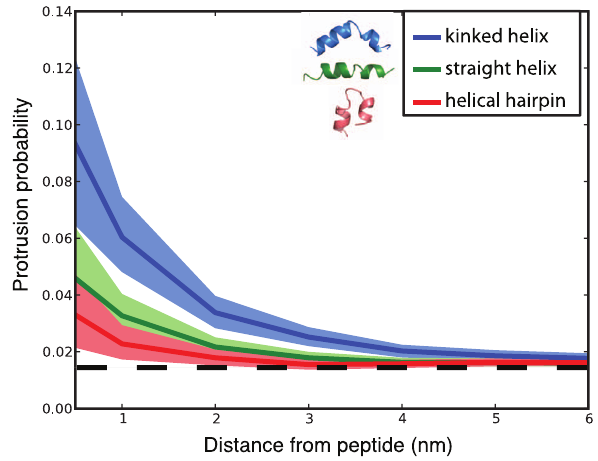
Figure 4. Kinked-helix conformations are most efficient at inducing lipid protrusion. Fusion peptide conformations were restrained to one of 3 models: a kinked helix (blue), a straight helix (green), or a helical hairpin (red). Lipid tail protrusion probability is plotted as a function of distance from peptide in the resulting simulations. Confidence intervals were calculated at 95% via bootstrap resampling. All simulations used residues 1–20 of the X-31 peptide sequence, restrained to each conformational model in